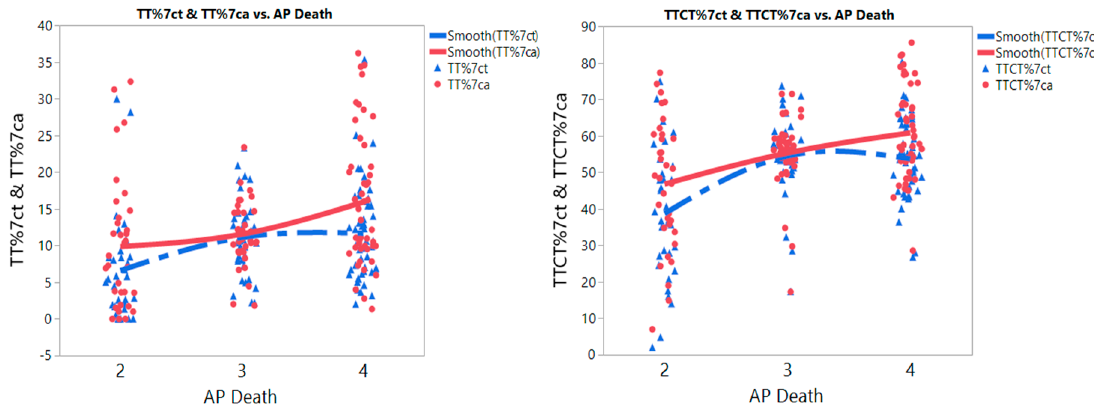
Figure 3. Nonlinear curve fits of MTHFR 677 polymorphism TT ( left ) and TT plus CT ( right ) genotypes of control and ischemic heart disease (IHD) groups with annual death rates from air pollution (AP death) per million population (levels: 2 = 51–100 deaths/million, 3 = 101–250 deaths, 4 = 251–400 + deaths); case = red, control = blue. Note. TT%7ct: Percentage of MTHFR 677 TT genotype in control group; TT%7ca: Percentage of TT genotype in IHD group; TTCT%7ct: Percentage of TT plus CT genotypes in control group; TTCT%7ca: Percentage of TT plus CT genotypes in IHD group.